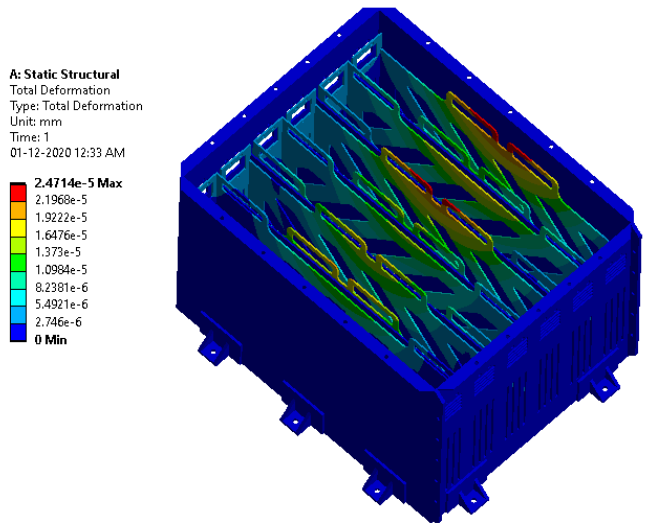
Figure 15. Static structural simulation due to cell weight under gravity results in negligible deforma- tion of 2.47 × 10 − 5 mm on the modules.